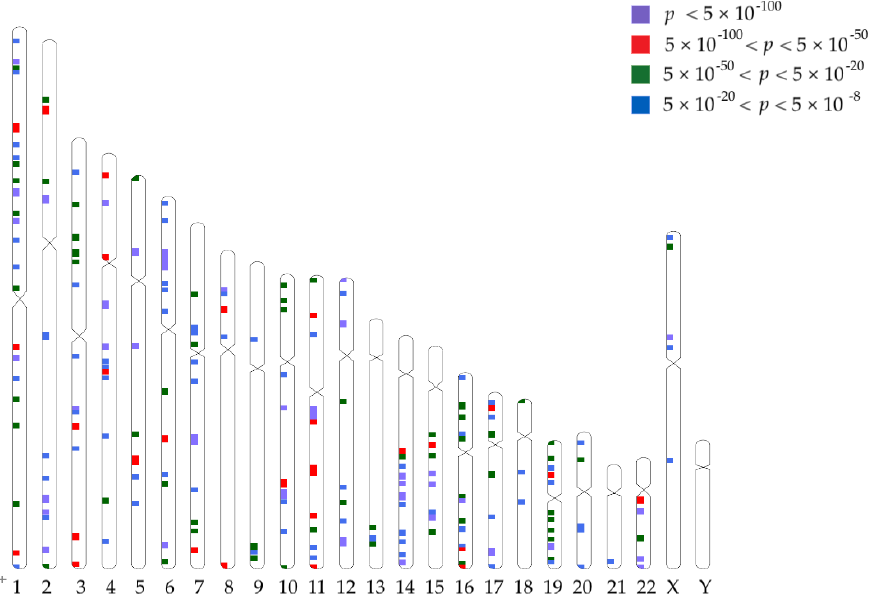
Figure 1. A plot of the locations of the main regions associated with metabolite levels in the discov- ery cohort.